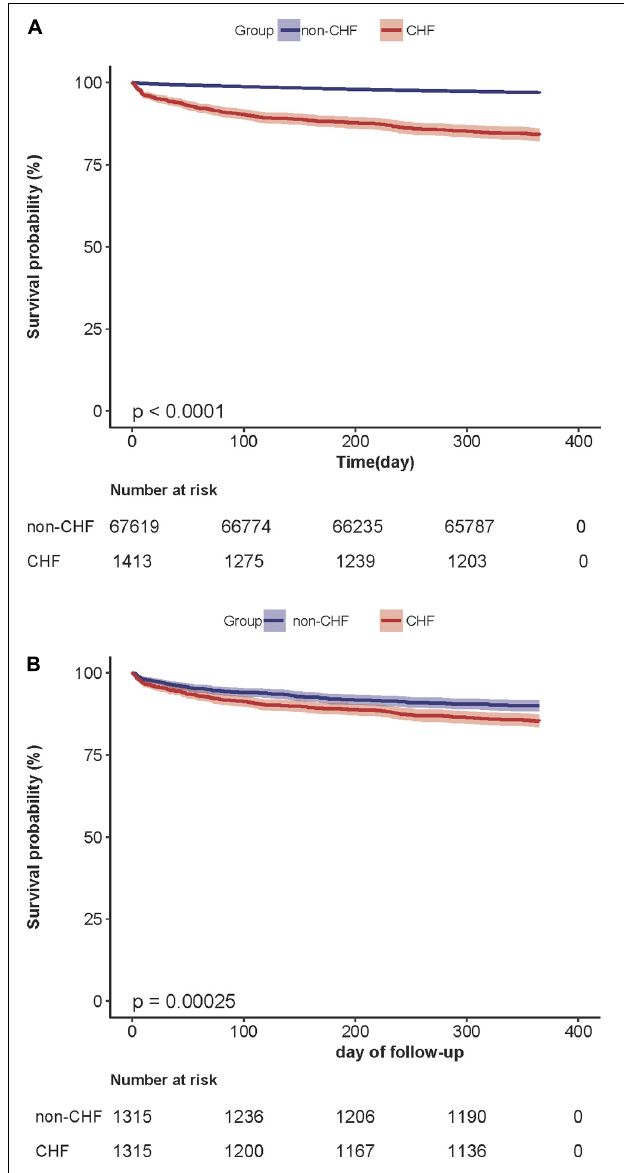
FIGURE 4 | (A) Kaplan–Meier survival curve based on congestive heart failure in the original cohort. Kaplan–Meier analysis of one-year mortality after surgery based on congestive heart failure(CHF) and non-congestive heart failure (non-CHF) in the original cohort(log-rank, P < 0.0001). (B) Kaplan– Meier survival curve based on congestive heart failure in the propensity-score matching cohort. Kaplan–Meier analysis of one-year mortality after surgery based on congestive heart failure (CHF) and non-congestive heart failure (non-CHF) in the propensity-score matching cohort (log-rank, P =